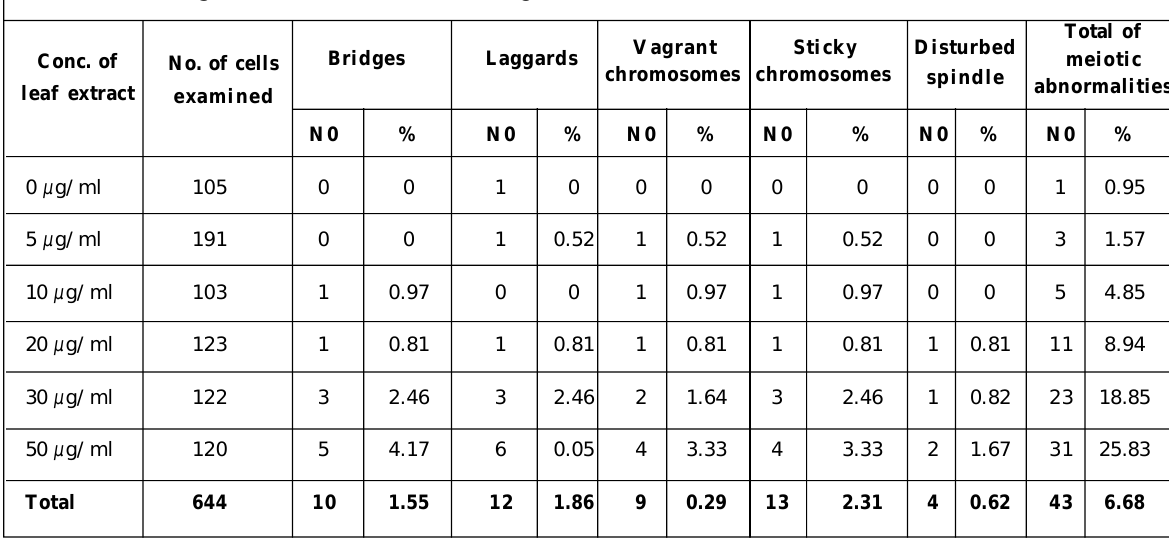
Table 1: Frequency of meiotic chromosome abnormalities induced by aqueous extract of C . lanatus on germ line cells of male Z. variegatus L. Conc.